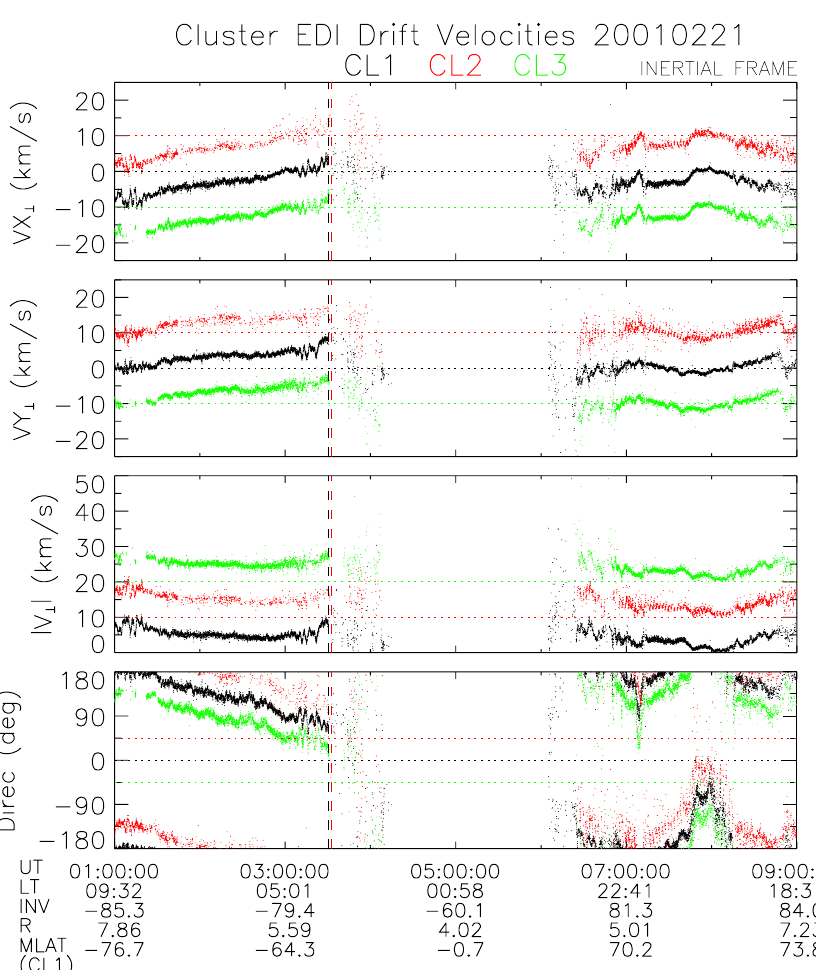
Fig. 8. Overview of drift velocities for 21 February in the same format as Fig. 4. Vertical dashed lines near 03:30 correspond to the first encounter with intense 1keV electrons, as marked in Fig.